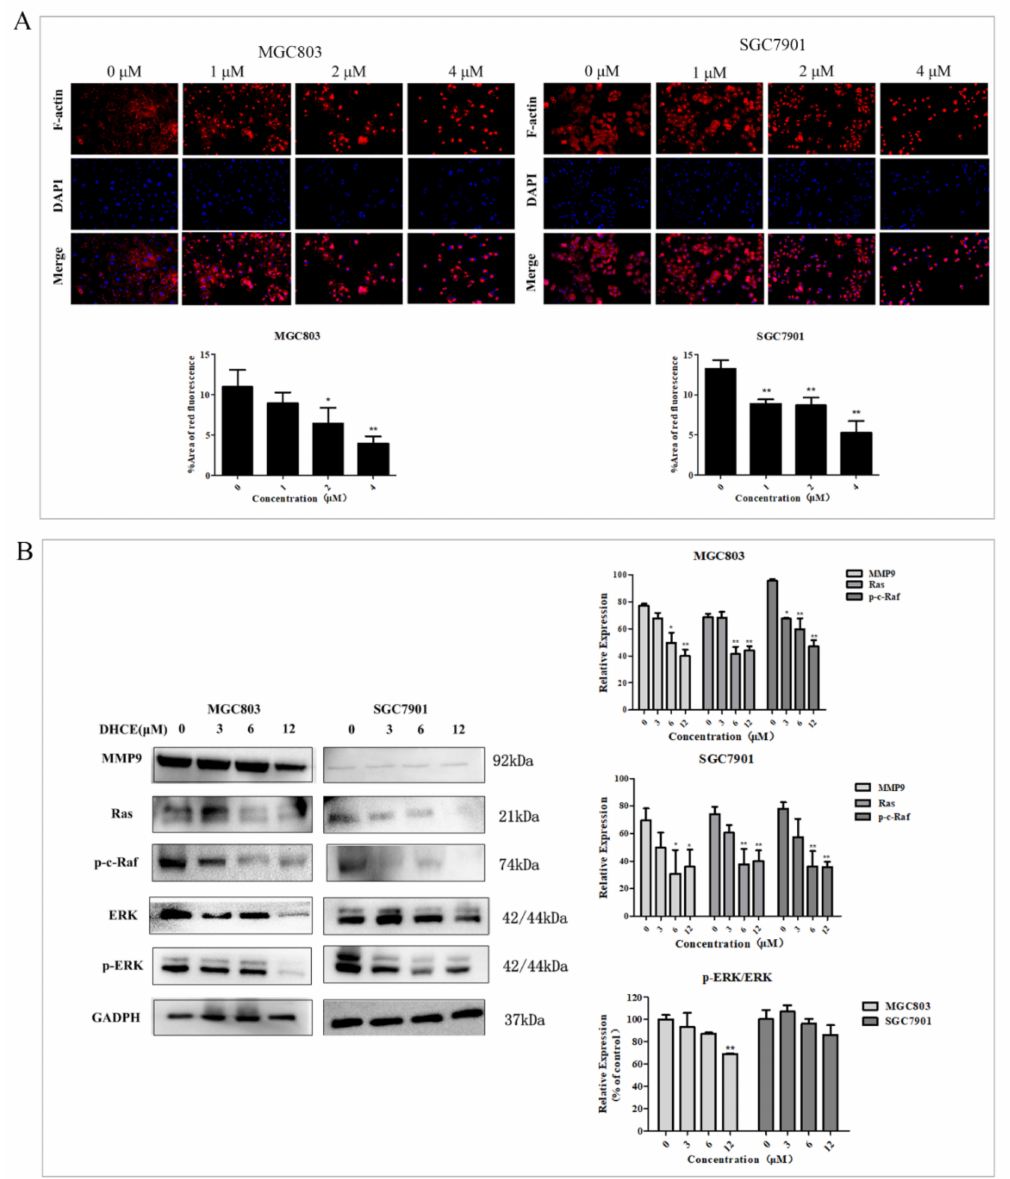
Figure 8. DHCE destroys cytoskeletal organization and attenuates the Ras/Raf/ERK/MMP9 pathway in gastric cancer cells. ( A ) The expression of F-actin microfilament was measured by Actin-Tracker Red-555 staining. The relative expression of F-actin microfilament was quantified by red fluorescence area. ( B ) Immunoblot analyses of MMP9, Ras, p-c-Raf, and p-ERK/ERK in MGC803 and SGC7901 cells treated with or without DHCE. The experiment was performed in triplicate, and the statistical results are expressed as the means ± SD (* p < 0.05 and ** p < 0.01 compared with the control